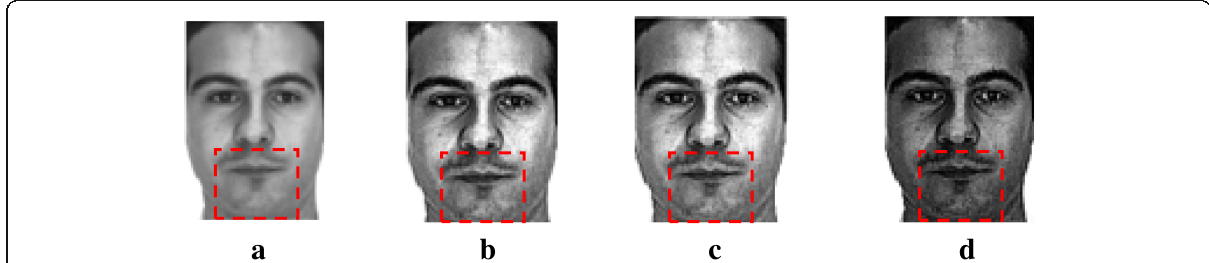
Fig. 3 Qualitative comparison of the different metaheuristic algorithm with our proposed evaluation function on Image 1. a Original. b CSO + proposed evaluation method. c PSO + proposed evaluation method. d GA + proposed evaluation